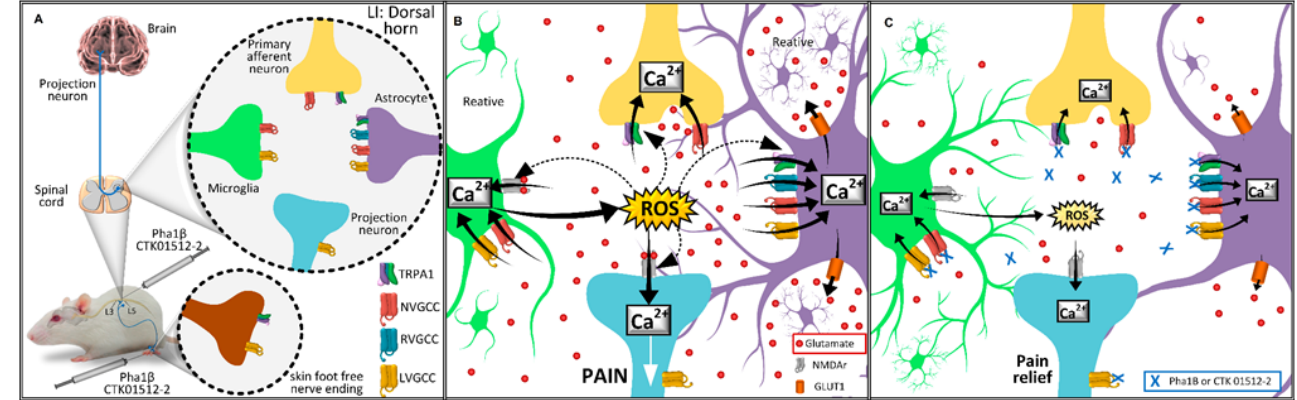
Figure 1. Molecular targets and action mechanisms involved in the intrathecal injection of Phα1β and CTK 01512-2 peptide. (A) Molecular targets of Phα1β and CTK 01512-2 and their cellular localization on the periphery tissue and lamina I of the spinal cord. (B) Phα1β and CTK 01512-2’s molecular target activation related events in spinal cord lamina I during pain states. (C) The suggested mechanism for pain relief through molecular targets blockade by Phα1β and CTK 01512-2. Note: more studies are necessary to understand how native peptides and their recombinant versions interact with HVCACC and